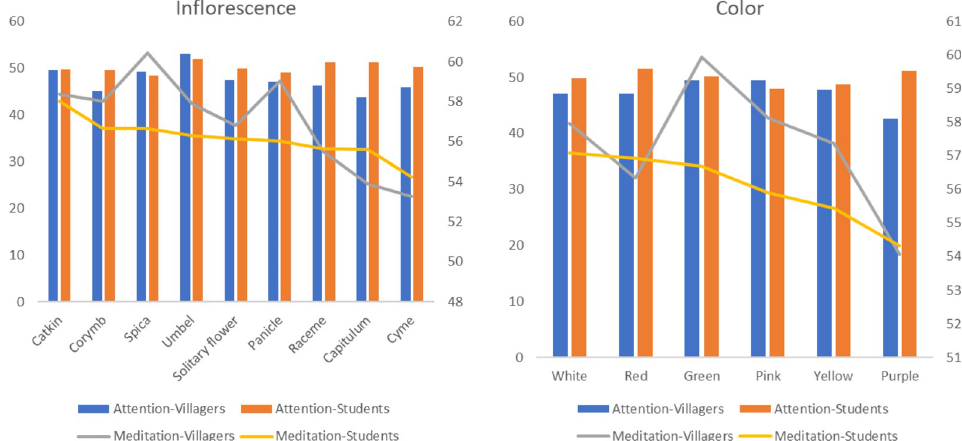
Fig 12. The average value of EEG indicators of villagers and students on different inflorescences and flower colours.